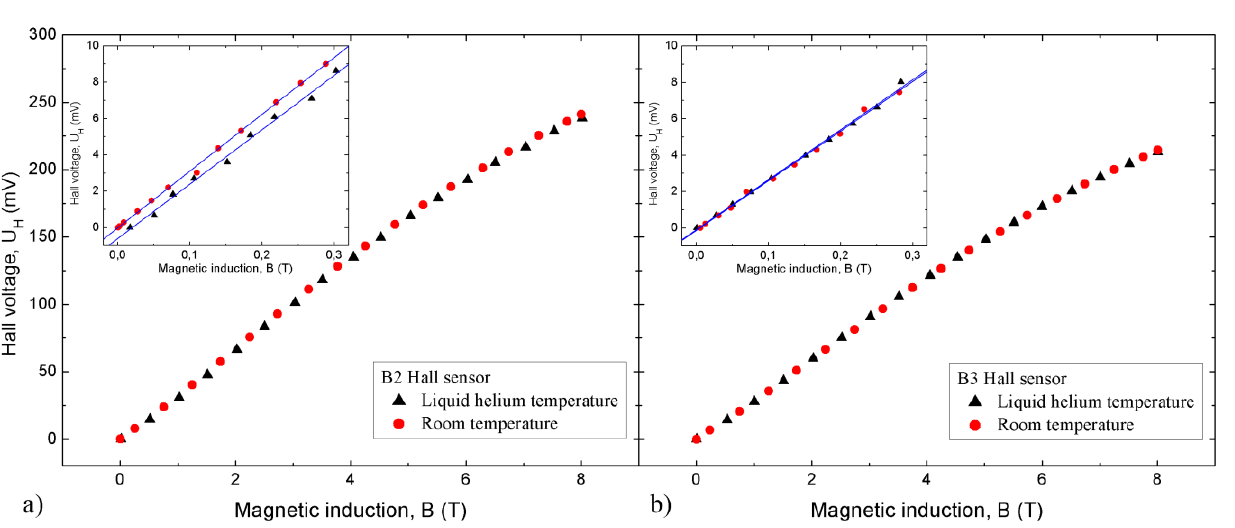
in range (0–8) T at 20 °C and −269 °C for H